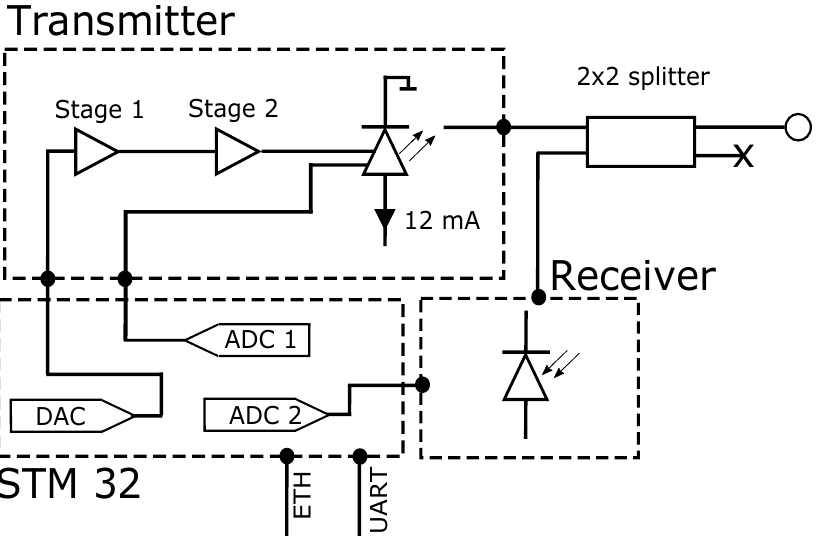
Figure 4. Schematic diagram of the developed interrogator. Two ADCs and one DAC of the micro- controller are utilized. The signal fed to the HCG input port is followed by a two-staged OPAMP. The signal from the photodetector is received by an ADC1, while ADC2 is utilized to measure the voltage on a thermistor built into the VCSEL. The laser is biased at 12 mA by a BJT-based